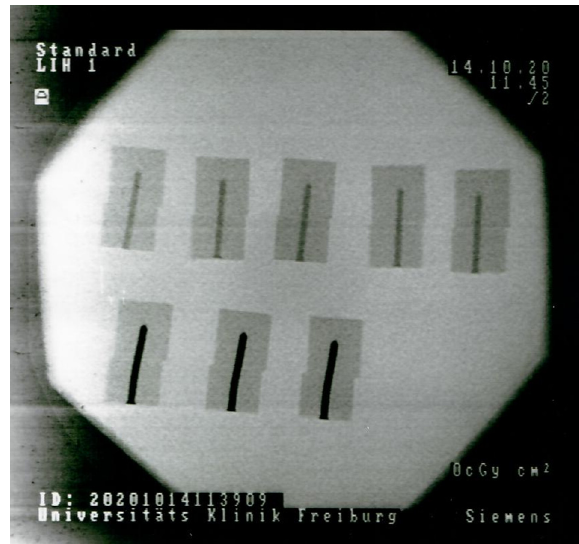
Figure 3. X-ray of the zinc pins (down low) and the MAGNEZIX pins (up high) after quasi-static testing and failure with Siremobil-ISO C from Siemens (Siemens AG, Munich, Germany).